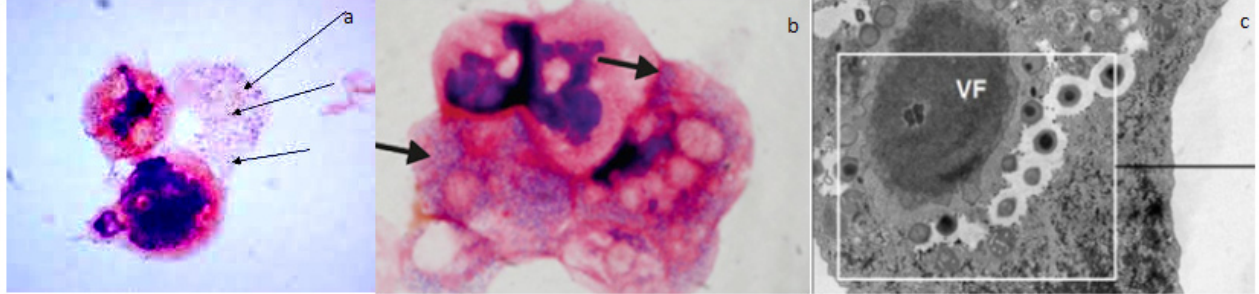
Figure 1. Premise picture. This picture illustrates Mimiviruses in the amoebas when first detected by the French authors 6 . Viral particles appeared as Gram-positive fine blue granules (black arrows) resembling bacterial cocci, from which the name Mimiviruses, was derived, i.e. Mimicking microbes. The blue gram positive granules in the cytoplasm of the amoeba ( A and B ) proved to be Mimiviruses and not bacteria when viewed using electron microscopy ( C ). Permission to use this picture was kindly provided by Prof La Scola